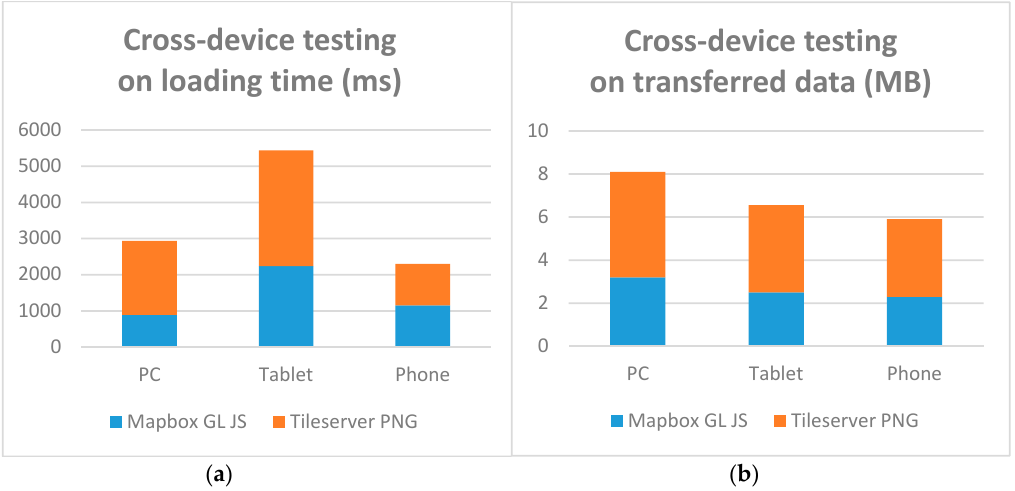
Figure 13. Results of cross-device testing: loading time ( a ); transferred data ( b ).